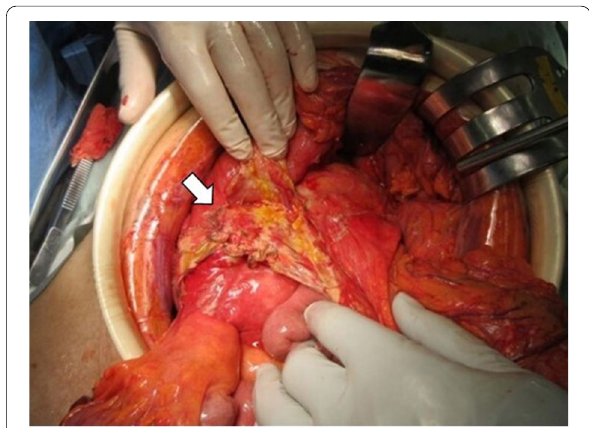
Fig. 2 Surgical view of case 1 showing the necrotic change of pancreas and peripancreatic tissue